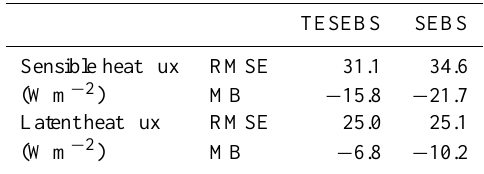
Table 1. The comparison between TESEBS and SEBS statistical